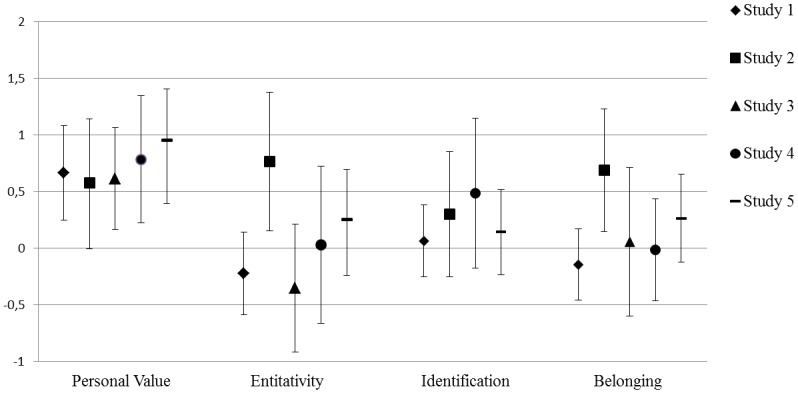
Contrast estimates (and 95% CIs) comparing the effects of complementarity and synchrony on personal value to the group and the three indicators of solidarity for Study 1–5.